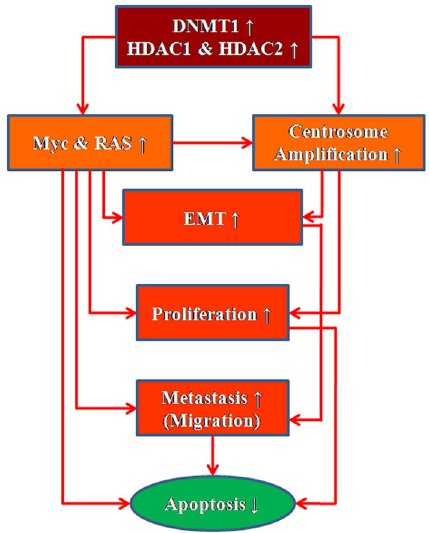
Figure 11. Schematic diagram showing DNA methylation and histone deacetylation-mediated chromatin remodelling modulate EMT via Myc/RAS pathway and centrosome amplification to regulate apoptosis in triple negative breast cancer